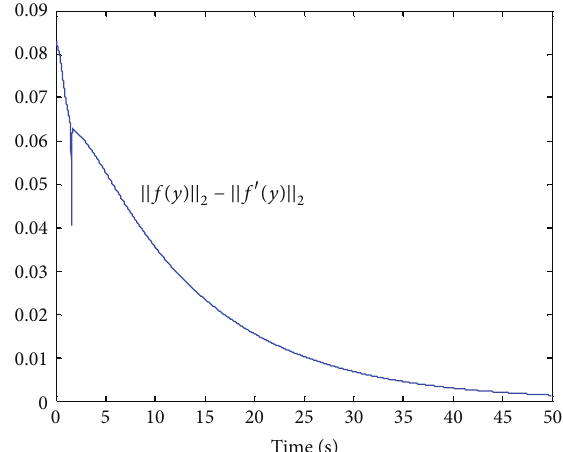
Figure 3: Relation between the 2-norms of the function, 𝑓(𝑦) , and its derivative, 𝑓 󸀠 (𝑦)